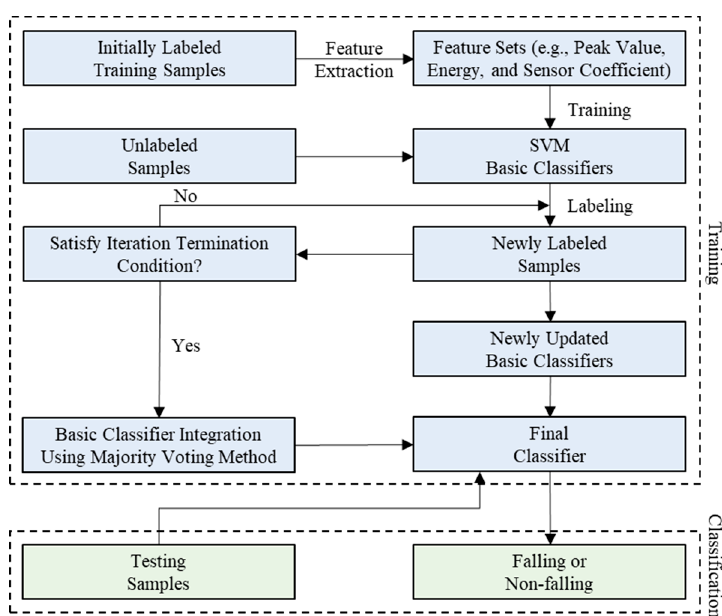
Figure 1. The proposed multi-features semi-supervised support vector machines (MFSS-SVM) framework.